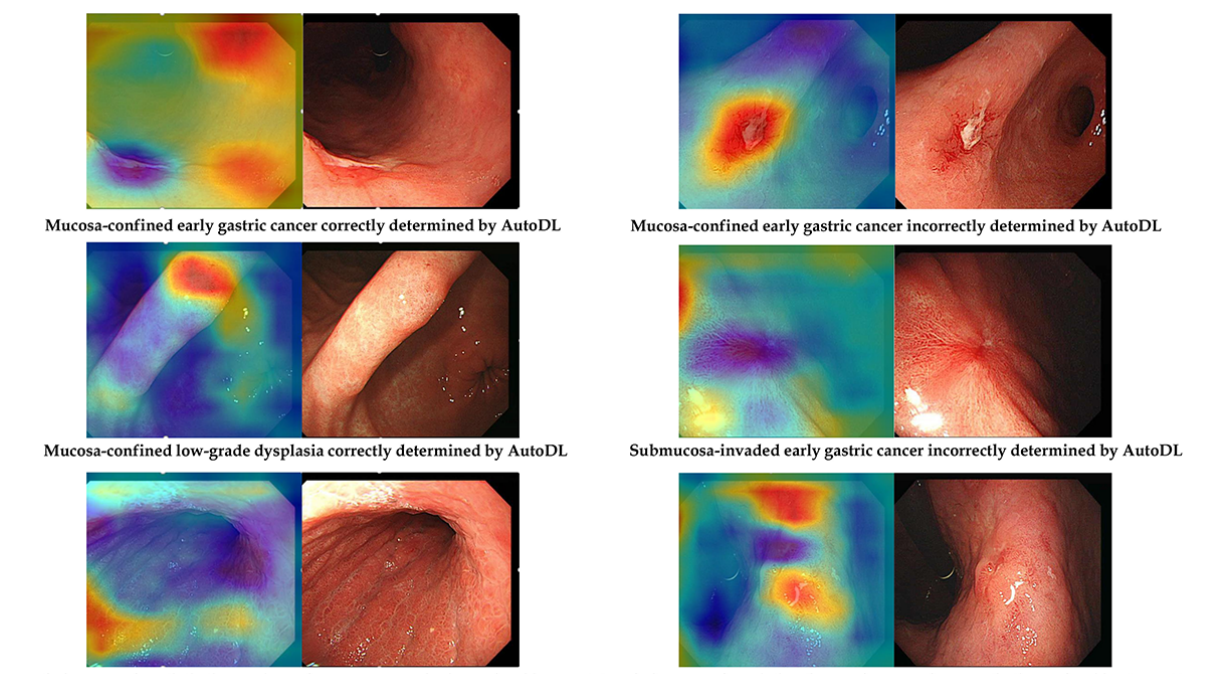
Figure 5. Representative samples of the attention map (Neuro-T–based model). AutoDL: automated deep